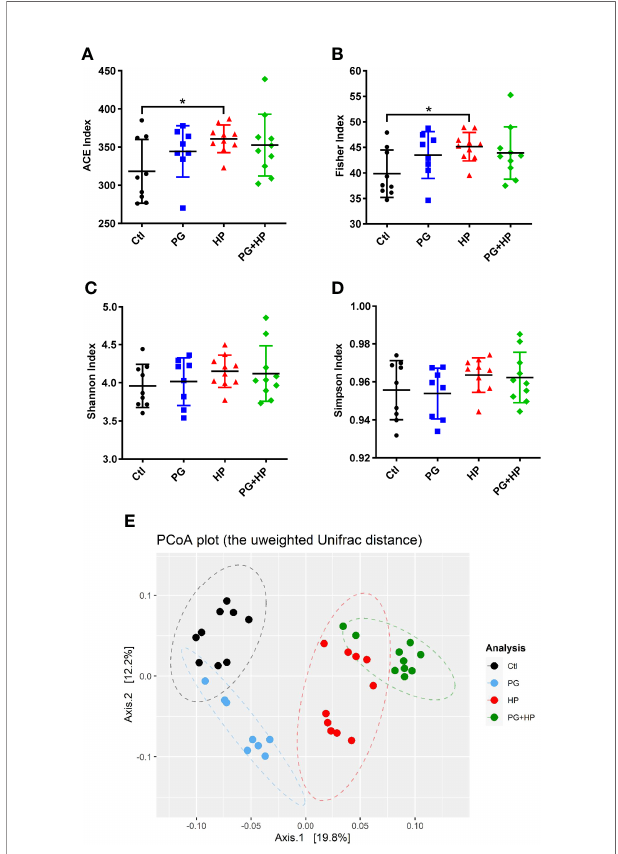
FIGURE 2 | P. goldsteinii MTS01 and H pylori alter the gut microbiota communities. Diversity index of (A) ACE, (B) Fisher, (C) Shannon, and (D) Simpson were performed to analyze microbiota diversity in murine intestinal stool. * P < 0.05 was assessed using Student ’ s t -test. (E) Analysis of the gut microbiota diversity. PCoA was conducted to analyze the gut microbiota composition in mice administered with vehicle-control (black), P. goldsteinii MTS01 (blue), H. pylori (red), and P. goldsteinii MTS01 + H. pylori